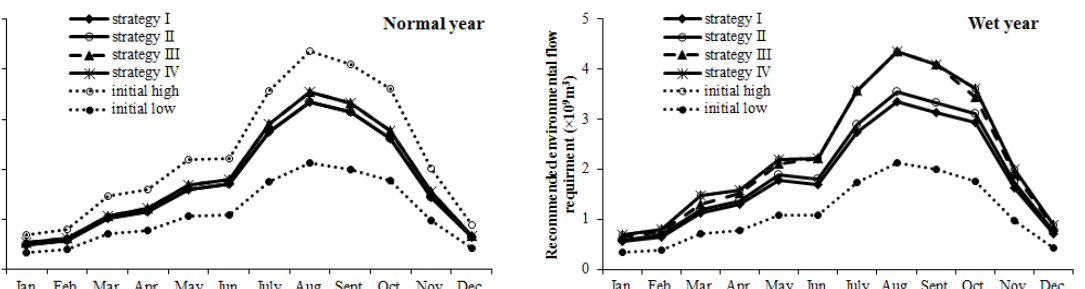
Figure 10 Fig. 10. The recommended environmental flow under different water management